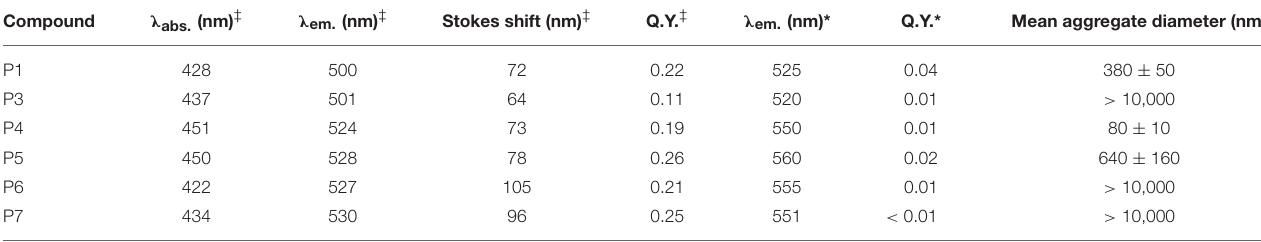
TABLE 1 | Summary of photophysical properties for compounds P1 and P3 – P7 .